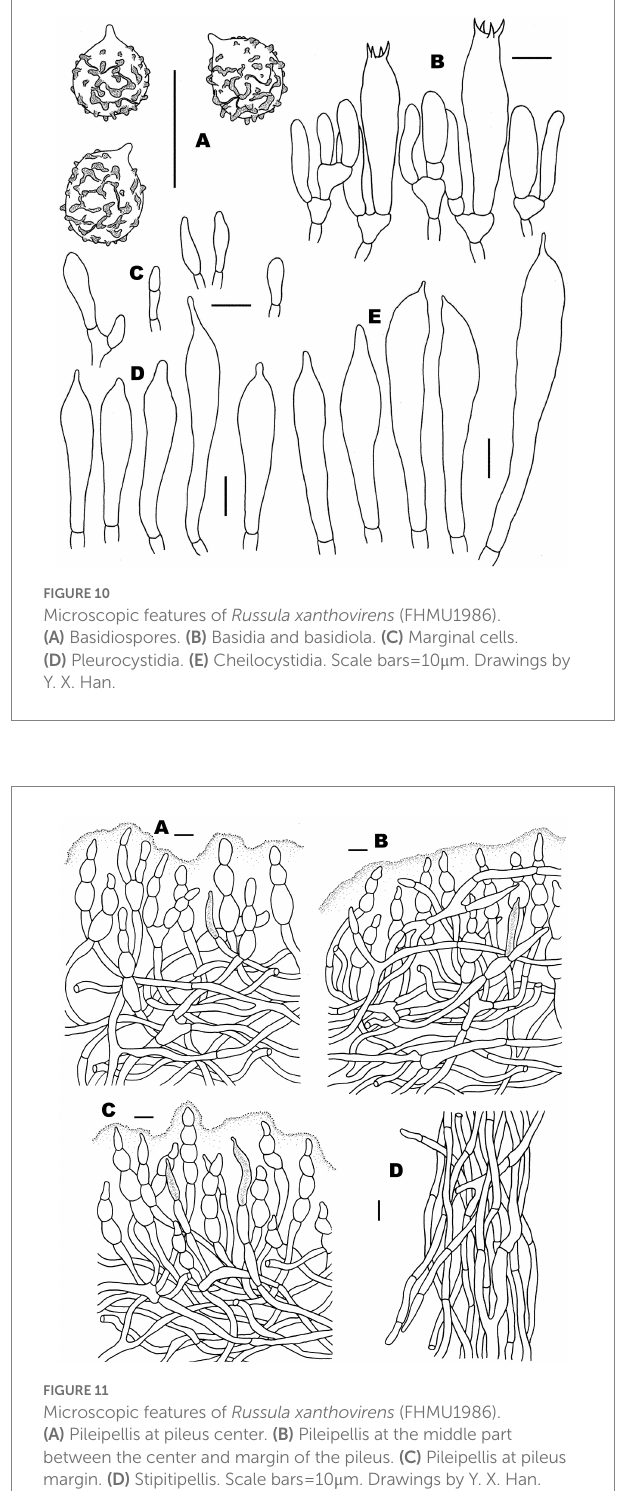
suprapellis (110–170 μ m thick) and subpellis (90–130 μ m thick). Suprapellis composed of erect to suberect hyphae 3–10 μ m in diameter, thin-walled (up to 0.4 μ m). Subpellis composed of horizontally oriented, 2.5–9 μ m wide intricate hyphae. Acid-resistant incrustations absent. Hyphal terminations near the pileus margin